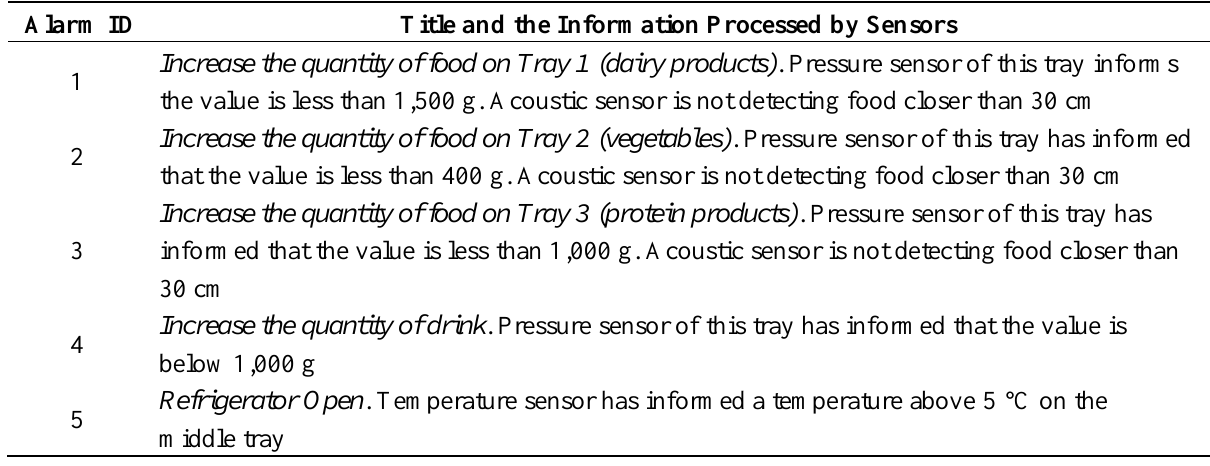
Table 2. Notifications of the Refrigerator appliance.